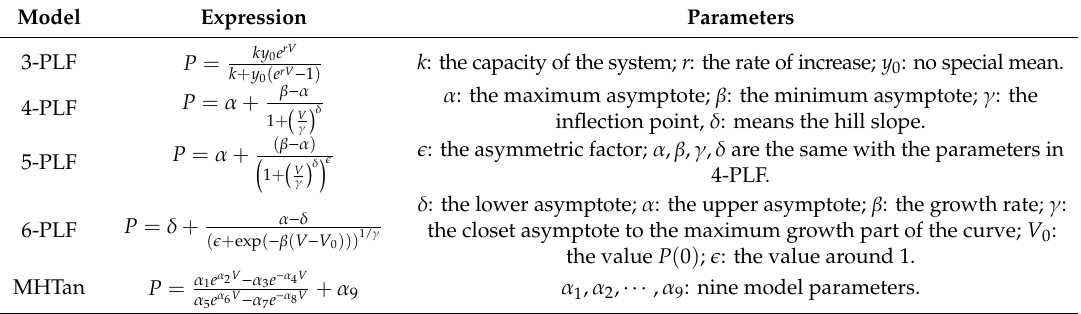
Table 1. Parametric wind turbine power curve